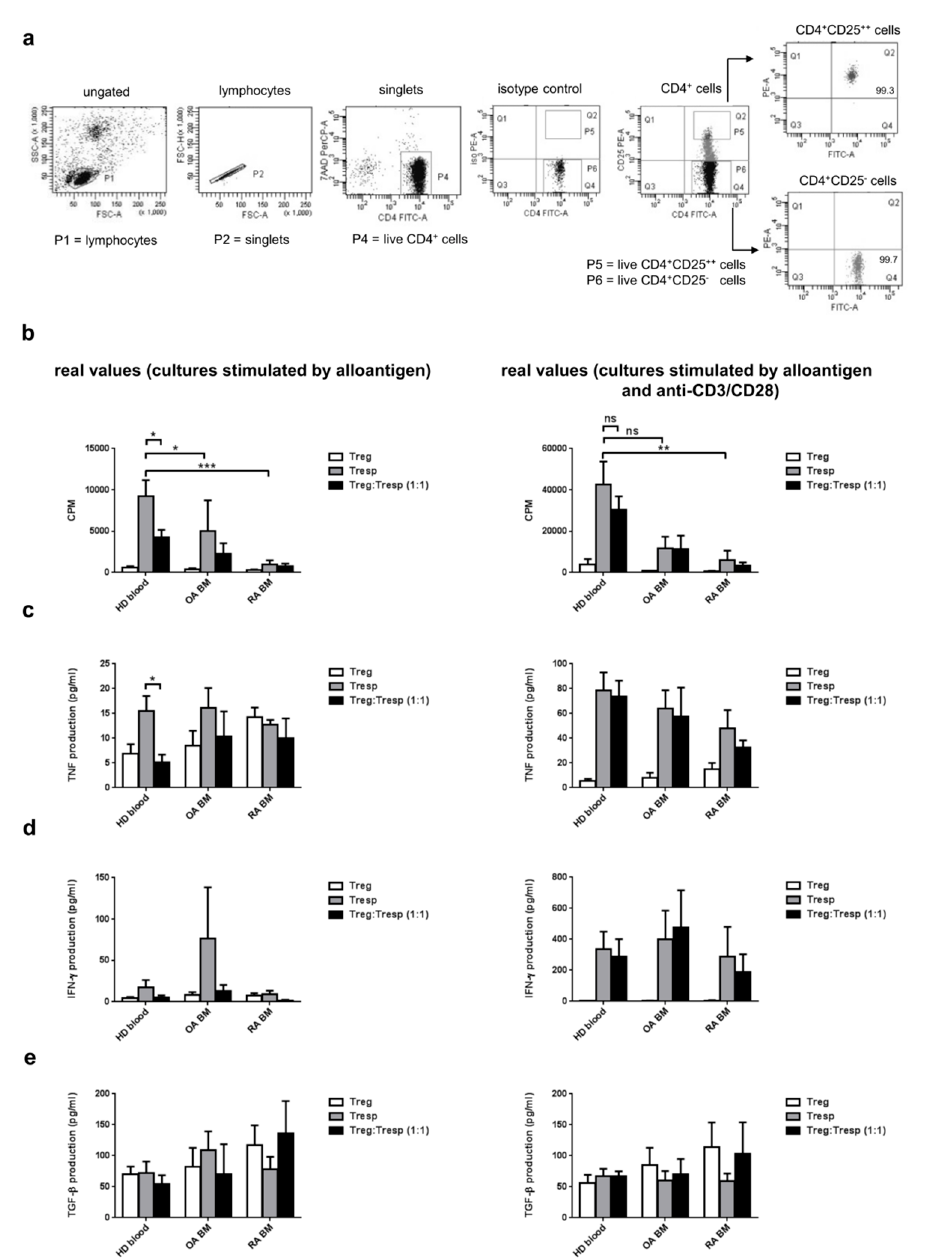
Figure 6. The suppressive potential of BM Tregs. ( a ) Representative sorting strategy for CD4 + CD25 ++ and CD4 + CD25 − subsets from the BM and peripheral blood (here OA BM is shown). ( b ) Proliferation of Tregs, responder T cells (Tresps) and their coculture is shown as real values (cpm). CD4 + CD25 ++ Treg and CD4 + CD25 − Tresp cells were isolated from the peripheral blood of healthy donors ( n = 10) and the BM of OA ( n = 7) and RA ( n = 8) patients. Detection of TNF ( c ) IFN- γ ( d ) and TGF- β ( e ) produced by Tregs, Tresps or their coculture is shown as pg / mL. Results were obtained from cultures of cells isolated from the peripheral blood of healthy donors ( n = 9) and the BM of OA ( n = 6) and RA ( n = 6) patients. ( b – e ) Statistical significance was calculated comparing results for Tresp with those obtained for Tresp cultured together with Treg. The di ff erences between the groups were tested for their statistical significance using parametric two-tailed T-test or Mann–Whitney U-test when the normality assumption was not met (GraphPad Software, USA). The results are shown as mean ± SEM. * p < 0.05, ** p < 0.01, *** p < 0.001; ns—not significant. HD blood—cells isolated from the peripheral blood of healthy donors; OA / RA BM—cells isolated from the BM of patients with OA / RA, respectively.